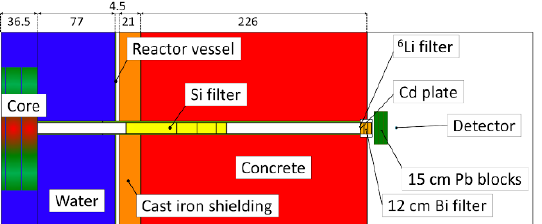
Fig. 2. The experimental arrangement in the reactor laboratory. The detectors were placed along the beam axis at 1.5 m distance from the silicon filter target [1].